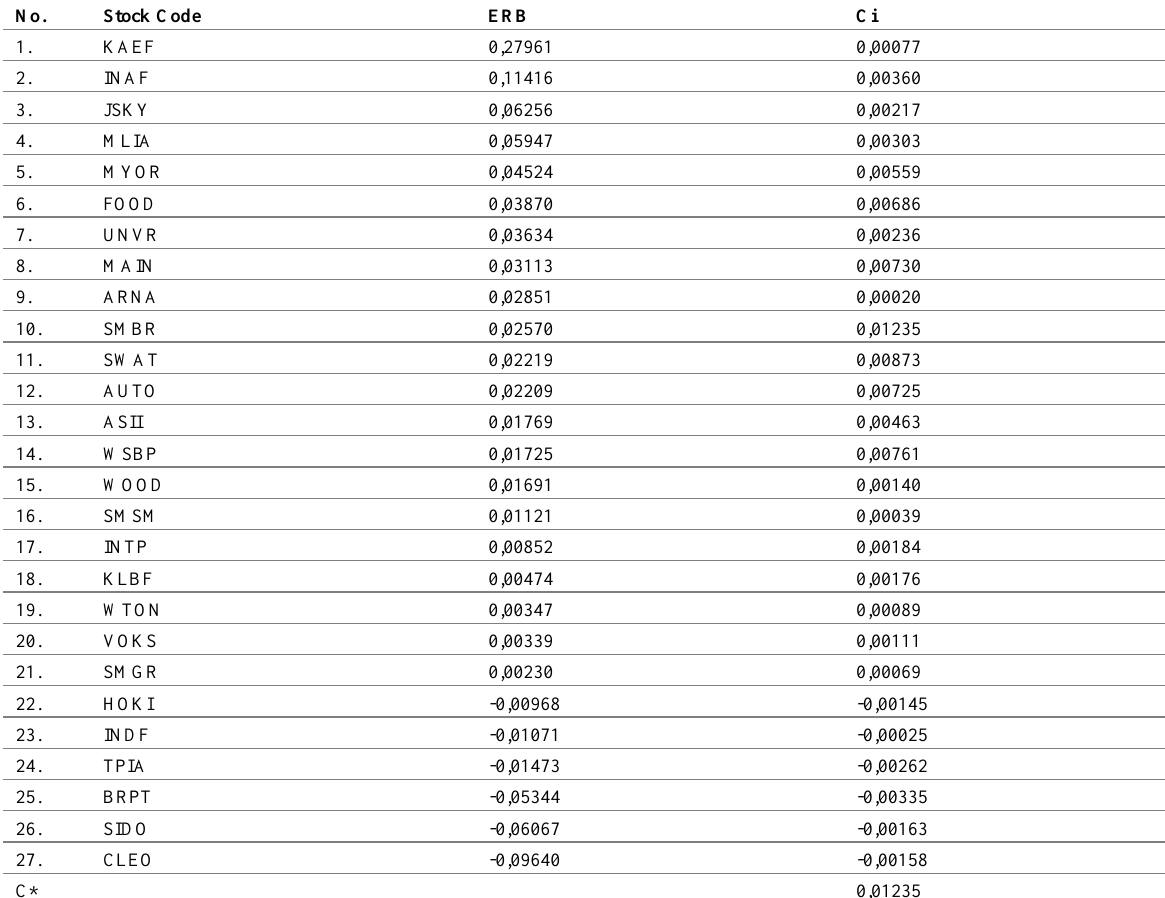
Table 4: Cut Off Rate (Ci) dan Cut Off Point (C*)